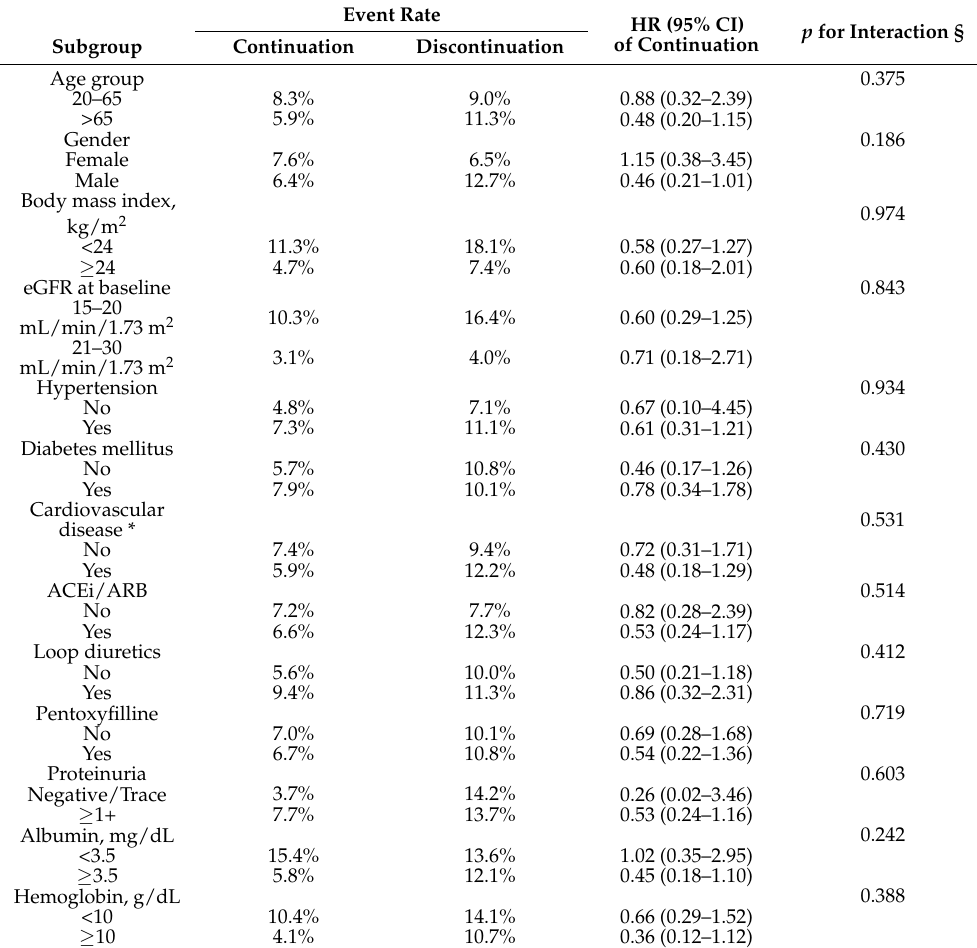
Table 4. Subgroup analysis of ESKD requiring dialysis during 1-year follow up in the IPTW adjusted